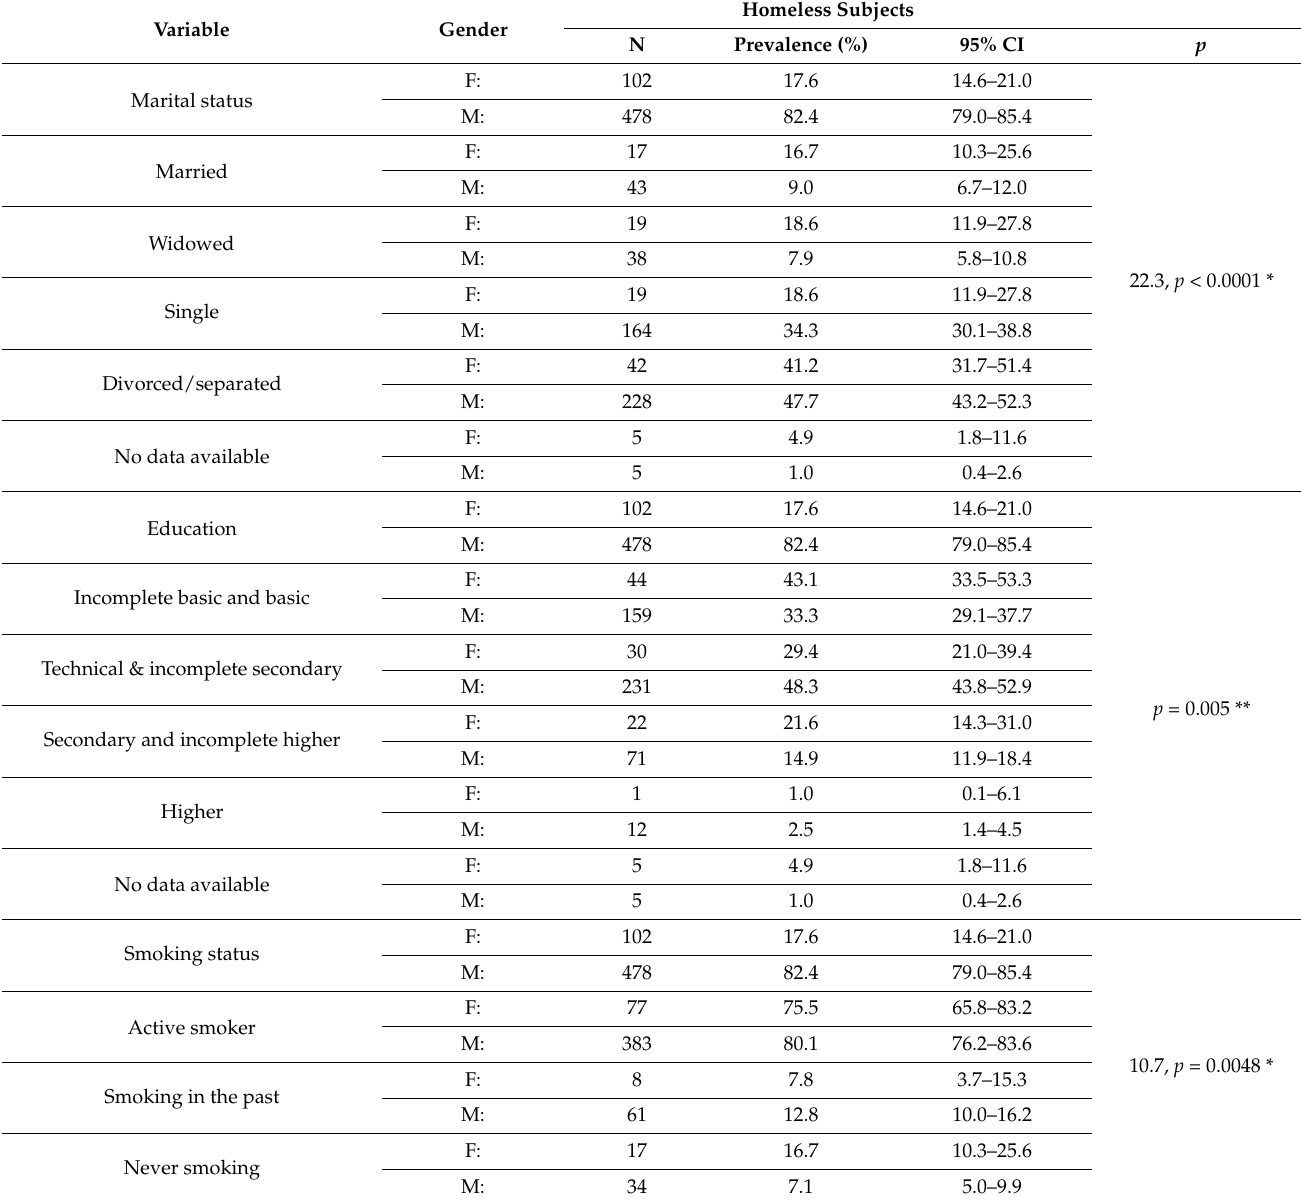
Table 1. Sociodemographic characteristics of the